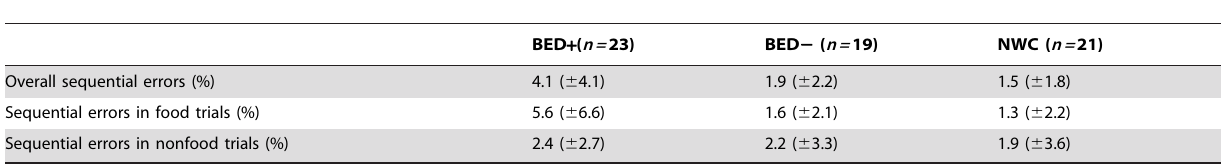
Table 2. Mean ( 6 standard deviation) for the percentage of sequential